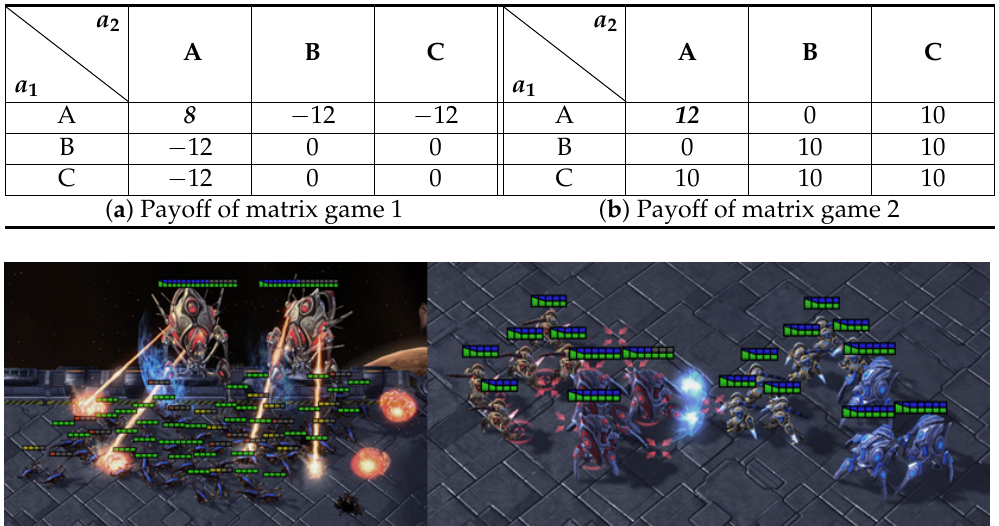
Table 1. Pay-off matrix of one-step game. Boldface means optimal/greedy actions from the state- action value. Both agents need to find the optimal joint actions as soon as possible.